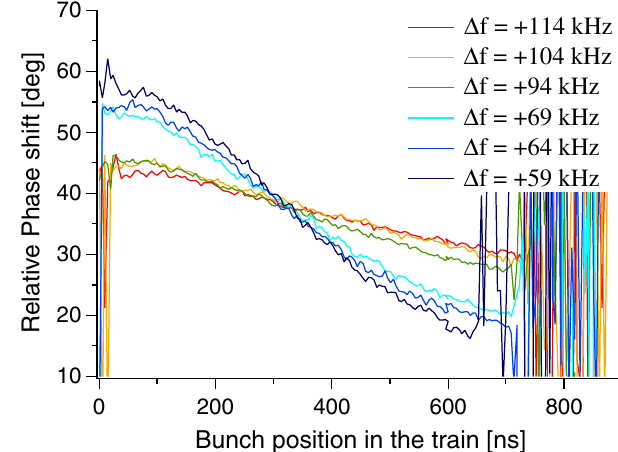
FIG. 6. (Color) Relative stable phase along the bunch train vs the 3HC detuning, for a 80% filling; I 2 : 0 GeV .